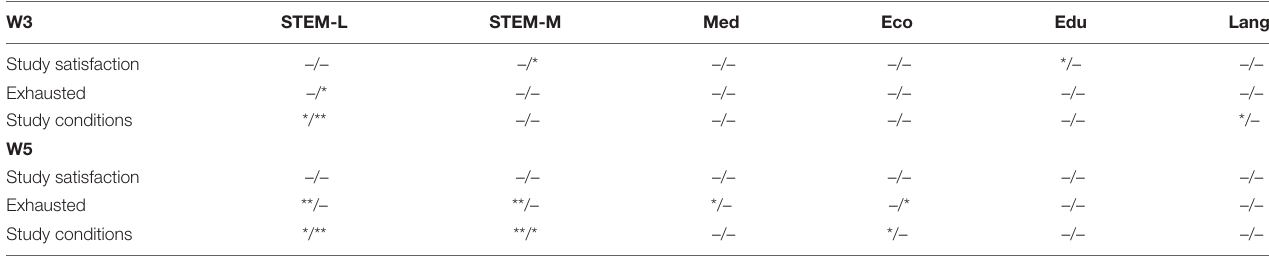
TABLE 6 | Areas with significant differences for the correlations between social congruence (SOC) and aspirational congruence (ASP) and satisfaction measures for all students and separate for the different study